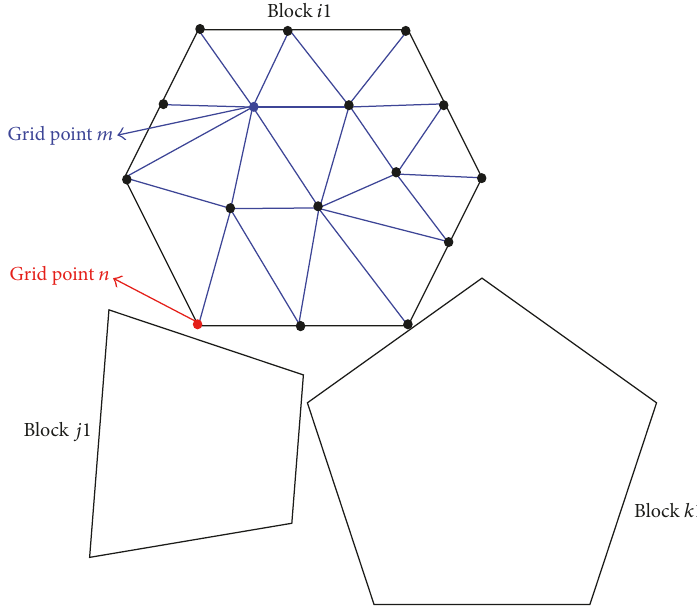
Figure 1: Deformable